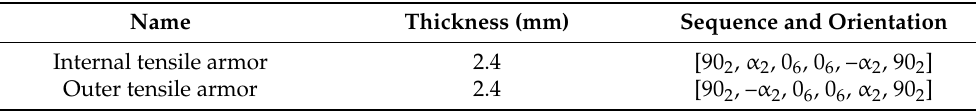
Table 5. The sequence and orientation of composite tensile